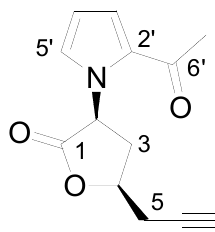
Figure 1. Structure of longanlactone.